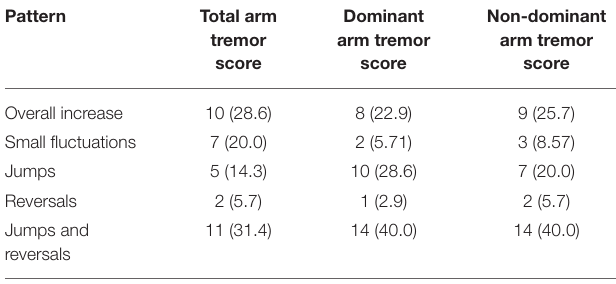
TABLE 3A | Frequency of tremor progression patterns following scheme 1 definitions.